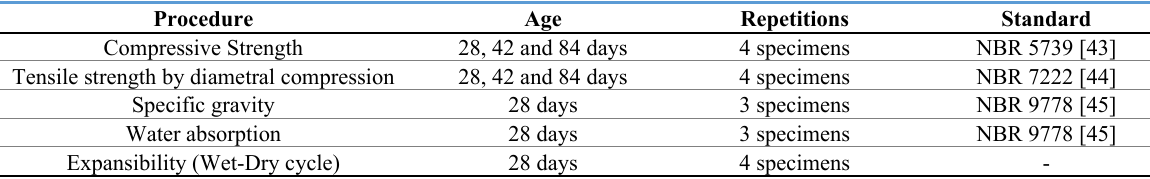
Table 4. Characterization program of hardened